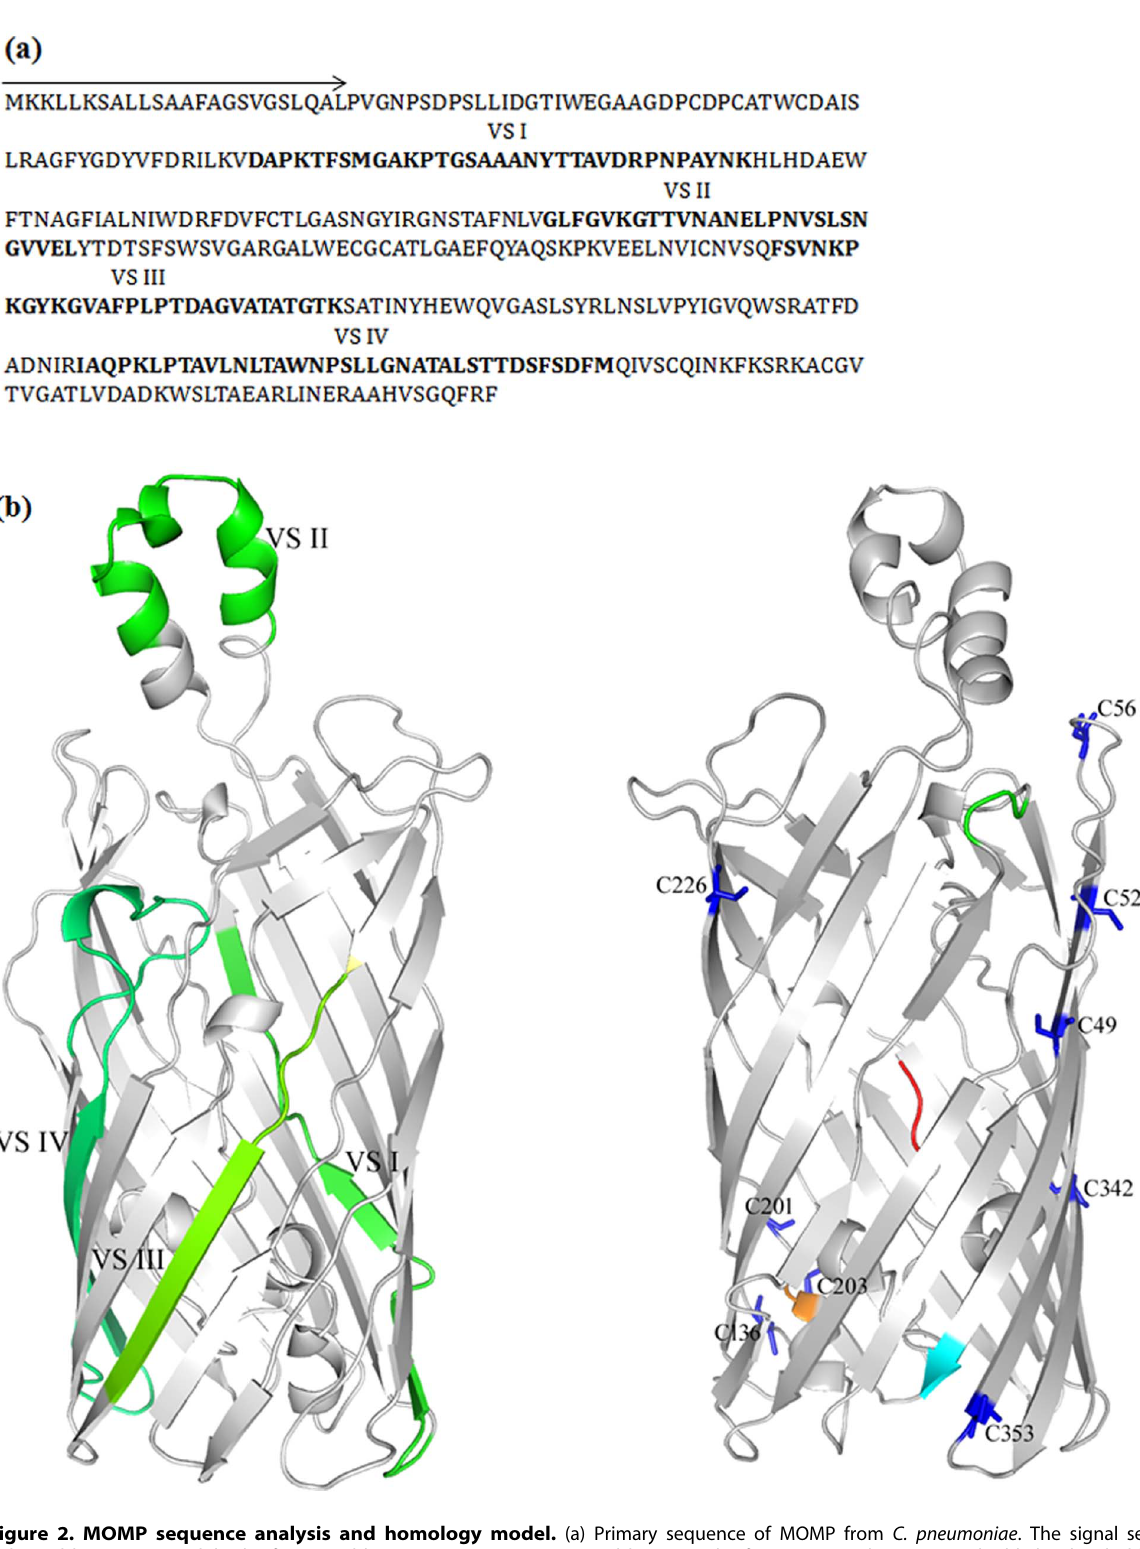
Figure 2. MOMP sequence analysis and homology model. (a) Primary sequence of MOMP from C. pneumoniae . The signal sequence is indicated by an arrow while the four variable segments (VS), interspersed between the five constant domains, are highlighted in bold. (b) Left - Cartoon representation of the homology model of MOMP from C. pneumoniae , showing the location of the four variable domains (green). VS I, III and IV are in the barrel while the protease accessible VS II is in the extracellular space. Right - Cysteine residues are highlighted in blue. The N- and C- termini are coloured red and cyan, respectively.